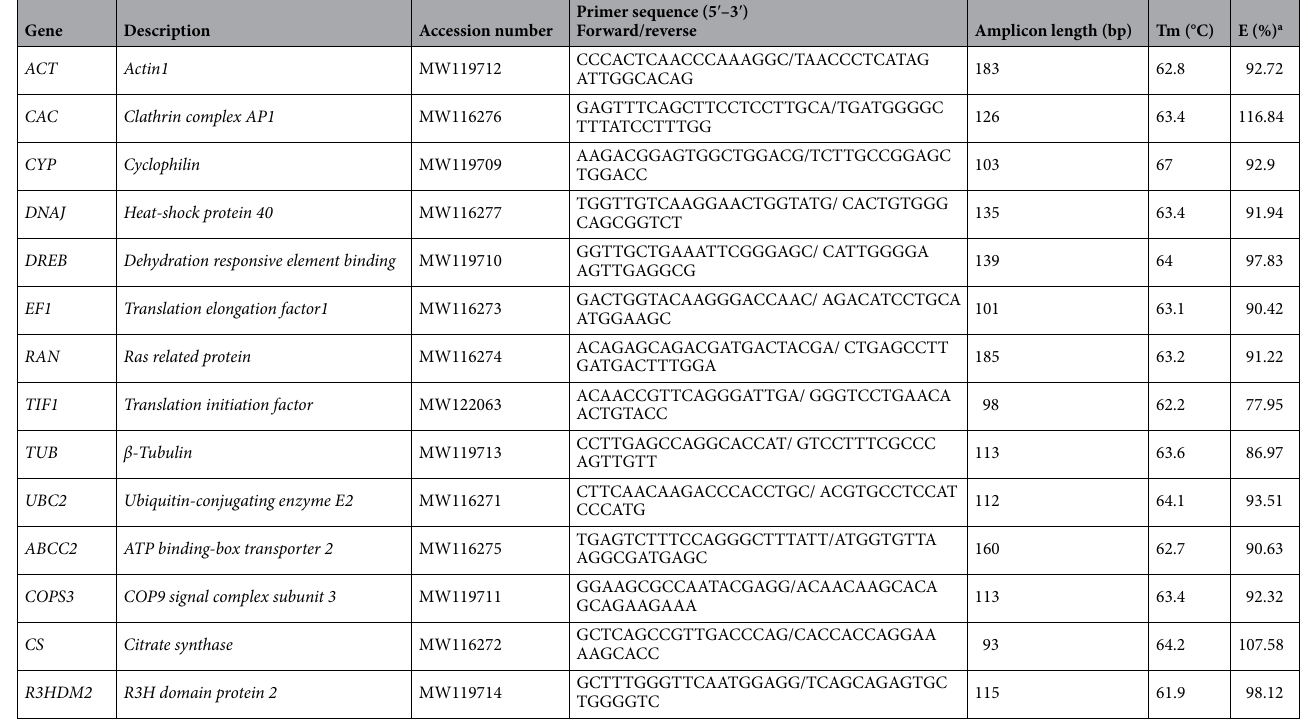
Table 1. Primers used in this study. a Amplification